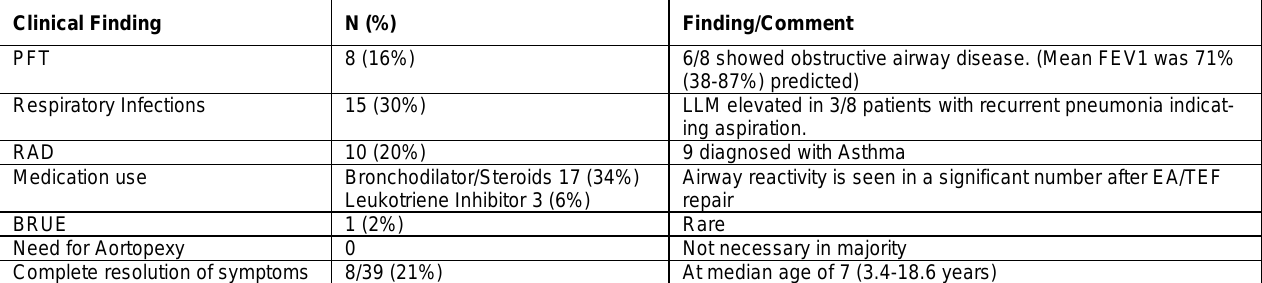
Table 2: Table summarizing clinical findings in this population. (PFT: Pulmonary Function Test; LLM: Lipid Laden Macrophages; BRUE: Brief Resolved Unexplained Event) Clinical Finding N